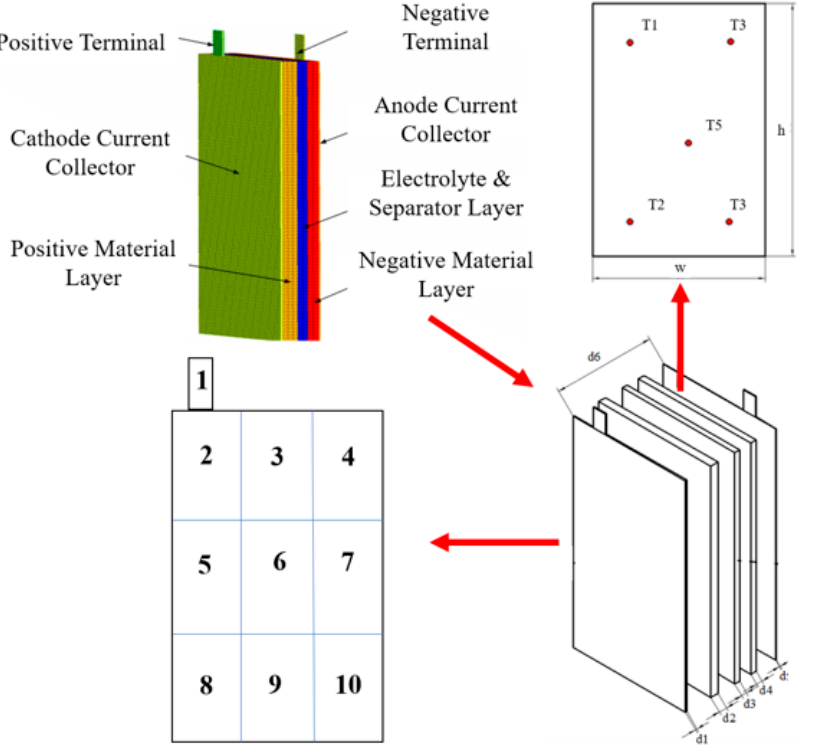
Figure 1. Schematic of model geometry and a computational mesh.